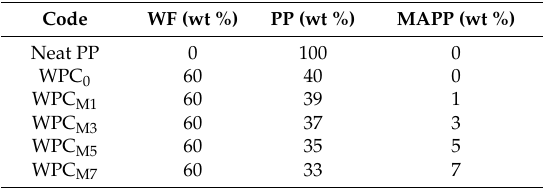
Table 1. Sample code and composition of the neat polypropylene (PP) and its